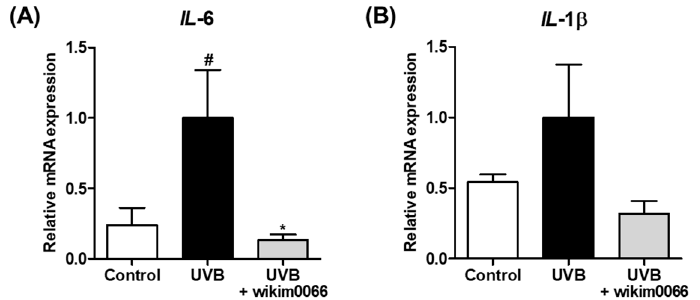
Figure 2. Effect of CFS from wikim0066 of IL-6 ( A ) and IL-1 β ( B ) mRNA expression on UVB-irradiated Hs68 cells. Cells were pretreated with 10% CFS of wikim0066 and irradiated UVB (30 mJ/cm 2 ), then treated with 10% CFS of wikim0066 for 3 h. The mRNA expression was normalized to that of GAPDH and presented as the mean ± SEM ( n = 3). # p < 0.05 vs. control and * p < 0.05 vs. UVB-control.